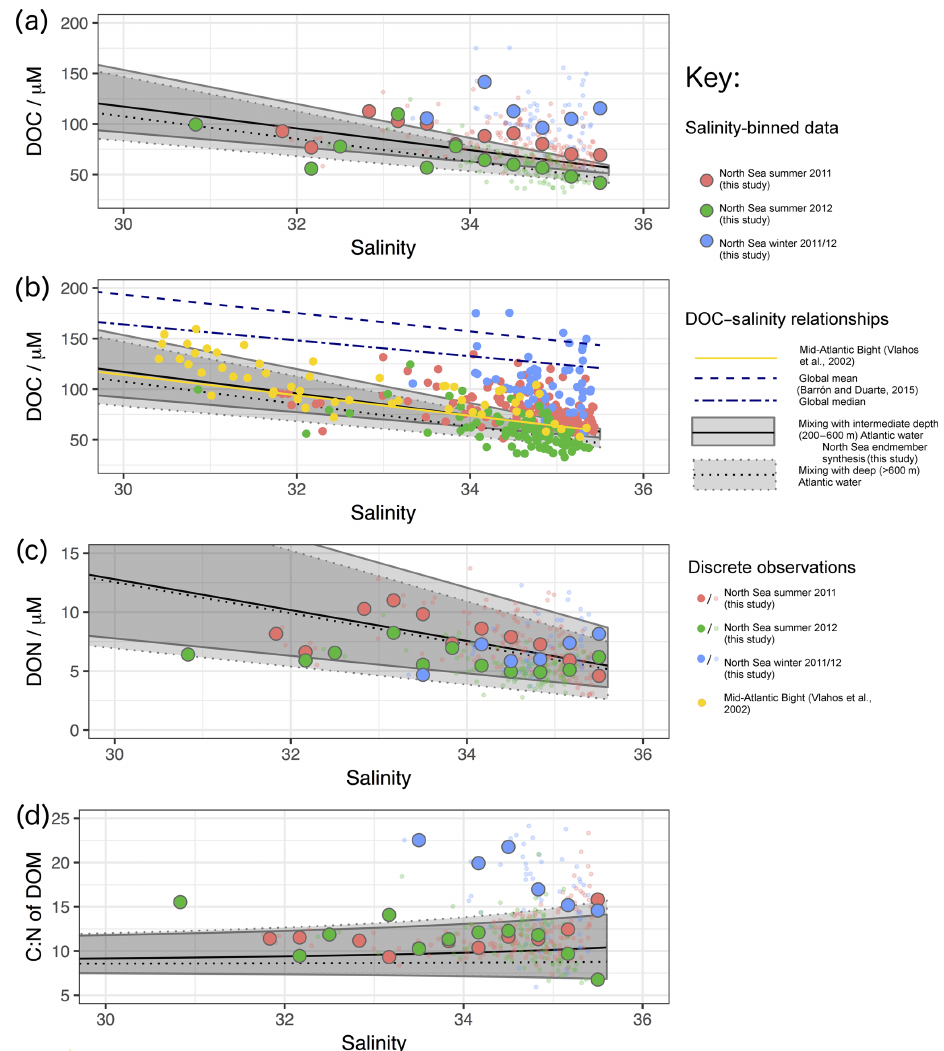
Figure 9. Comparison of (a) DOC, (c) DON and (d) C : N relationships with salinity, compared to conservative mixing predictions. Small points represent discrete observations and large points are binned averages spaced at one-third of a salinity unit. The solid and dotted grey lines and areas represent predicted conservative mixing lines between rivers and the shallow and deeper Atlantic endmembers, respectively. In panel (b) DOC data from this study are compared to the data (yellow dots) and salinity relationship (yellow line) of Vlahos et al. (2002) in the MAB, as well as the mean (long dash) and median (long dash, short dash) relationships from the global synthesis of Barrón and Duarte